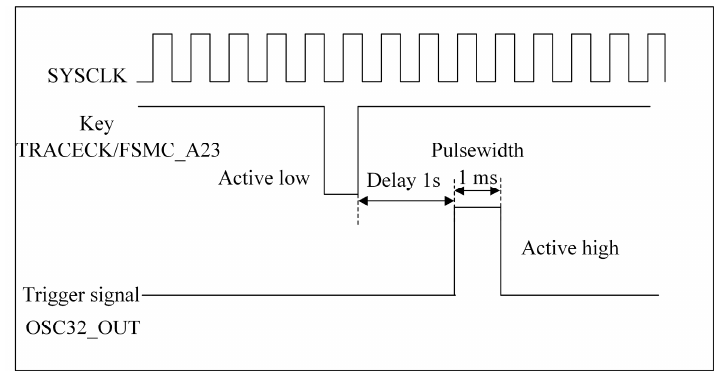
Figure 10. SCM trigger sequence of trigger circuit.